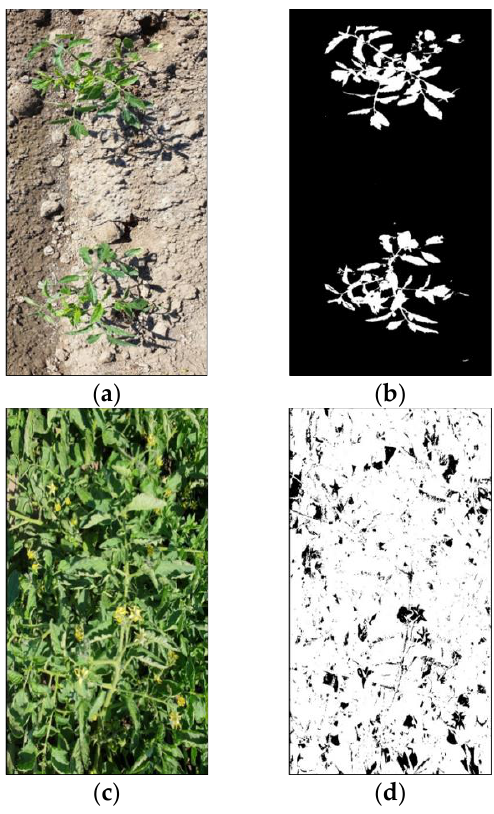
Figure 3. Examples of high-resolution pictures taken on the 5th of May ( a ) and the 4th of June ( c ), along with their processed binary images ( b – d ) that were analyzed with the Canopeo software to evaluate the canopy